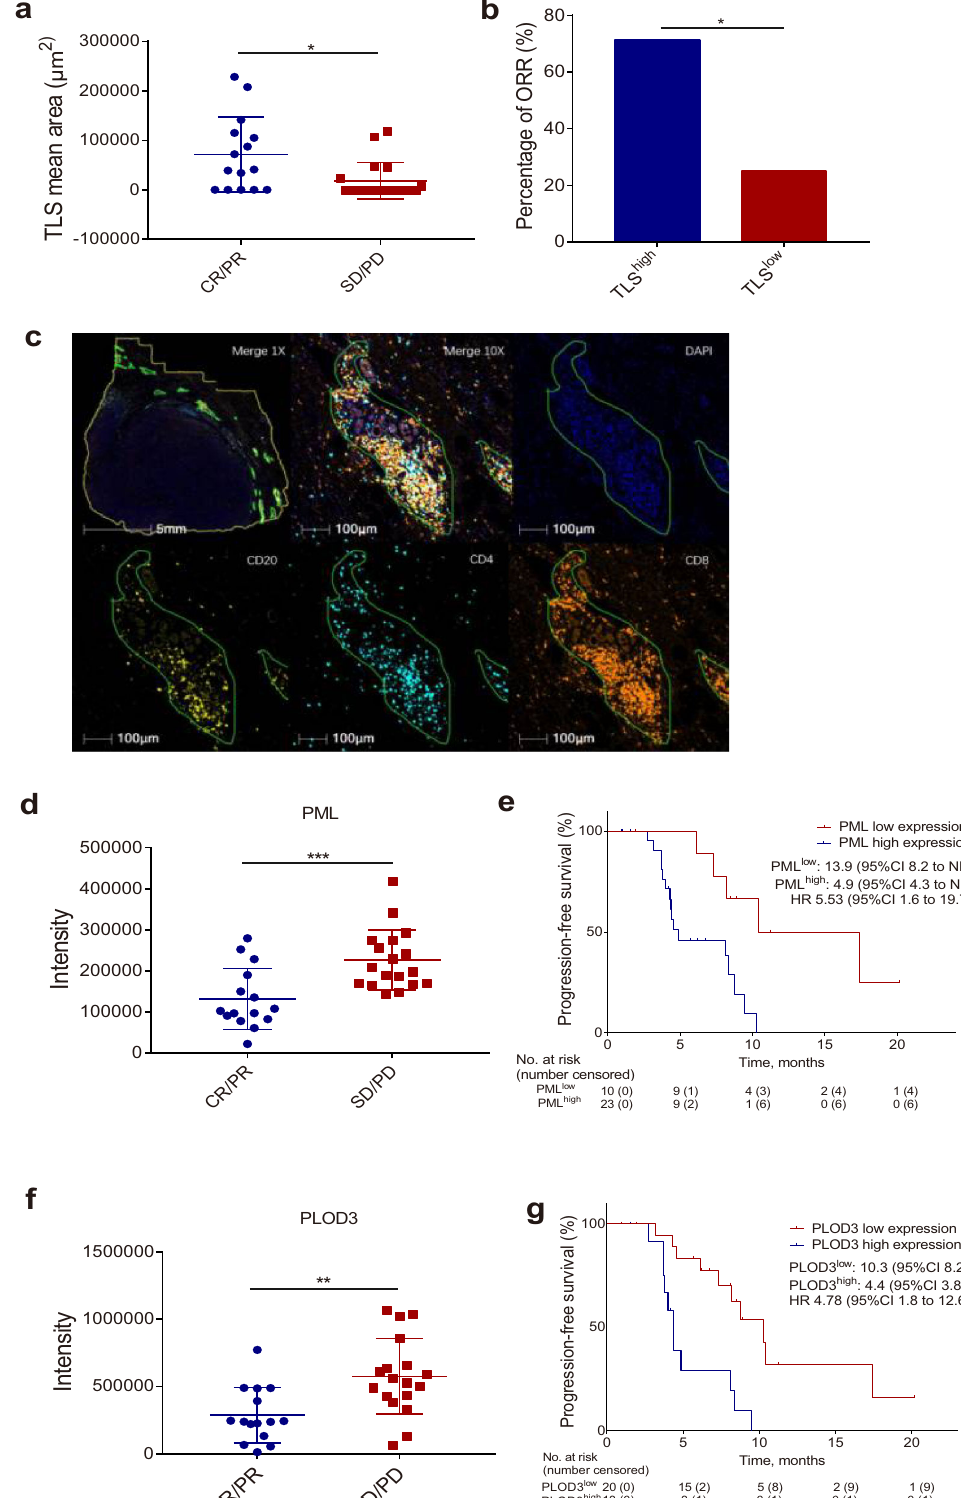
PLOD3 low expression PLOD3 high expression PLOD3 low : 10.3 (95%CI 8.2 to NR) PLOD3 high : 4.4 (95%CI 3.8 to NR) HR 4.78 (95%CI 1.8 to